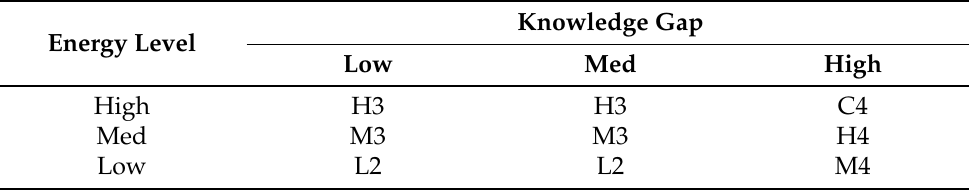
Table 4. Using energy level and knowledge gap to determine amount of damage (Low, Medium, High, Catastrophic) and distance to potential victims (1st party, 2nd party, 3rd party, 4th party). Adapted from Reference